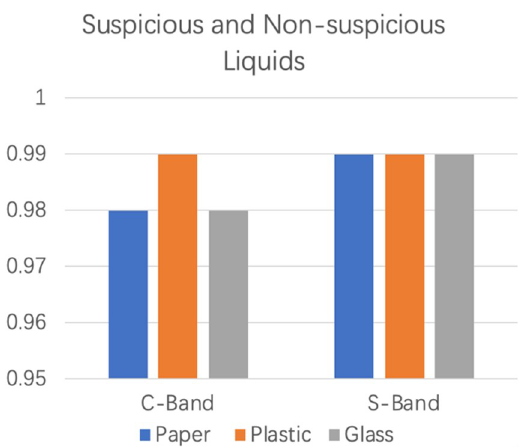
Figure 5. Amplitude information of 30 subcarriers of Step 1 at the S-band. ( a ) Using the paper cup; ( b ) Using the plastic bottle; ( c ) Using the glass bottle.